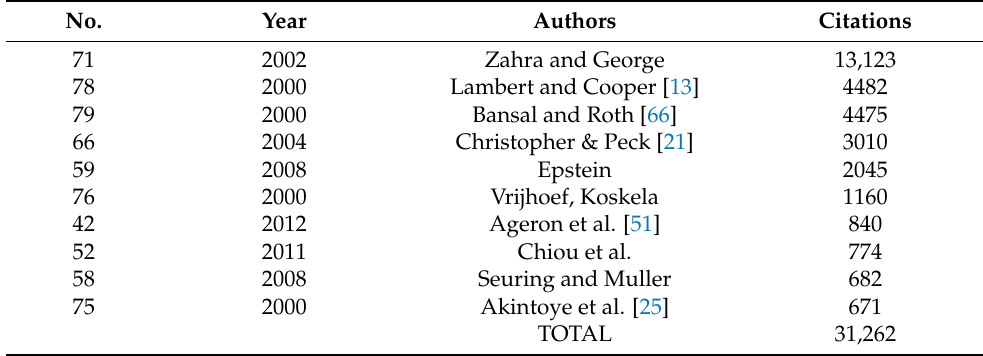
Figure 2. Annual number of scientific articles published between 2000 and 2020. Table 2. Top 10 citations for the responsible sourcing publications used in this